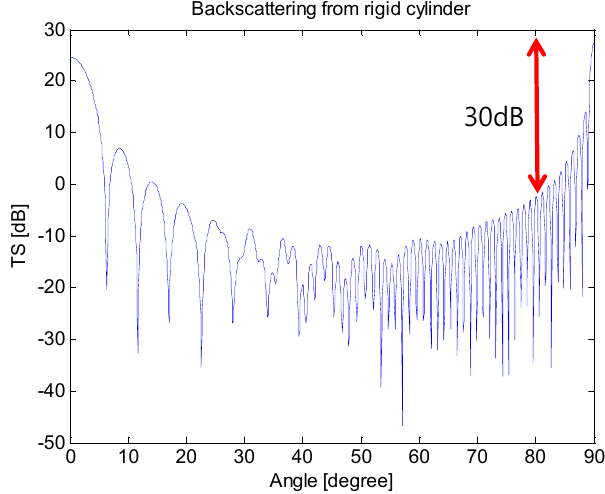
Figure 3. Target strength of a rigid cylinder with respect to rotation